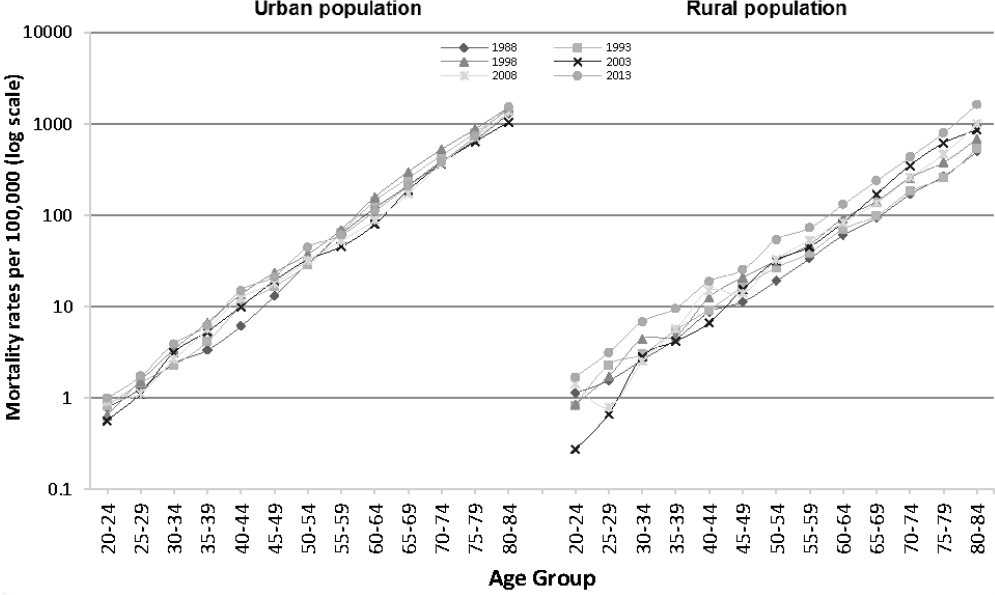
Figure 2. Age-specific IHD mortality in urban and rural China, by time period.